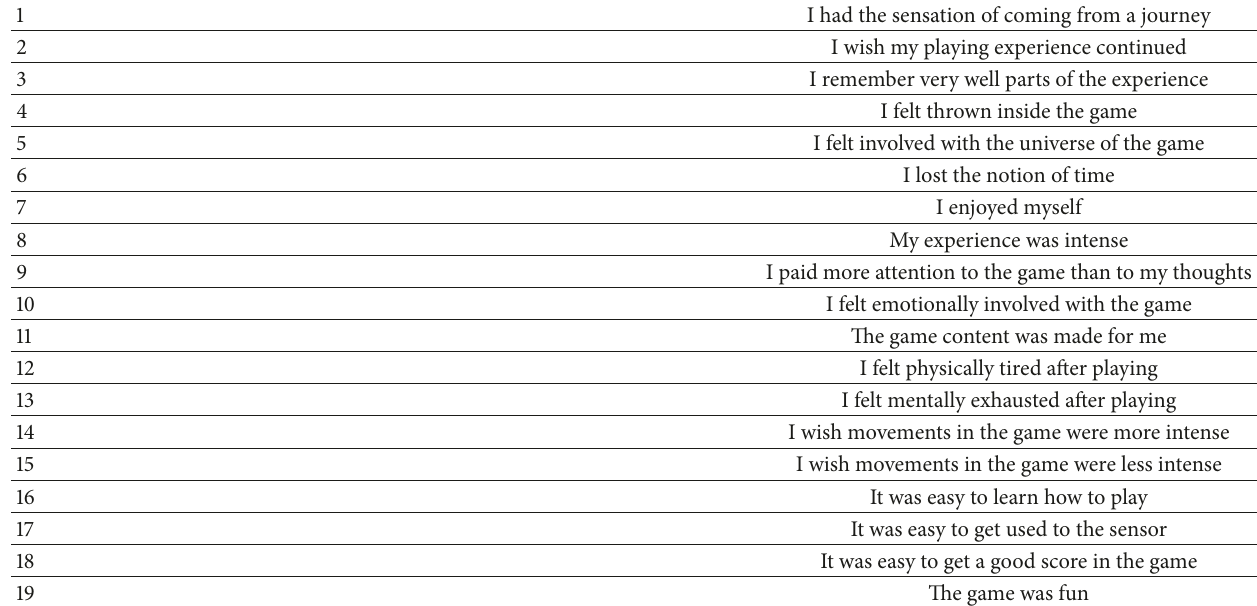
Table 9: Posttest questionnaire, translated from